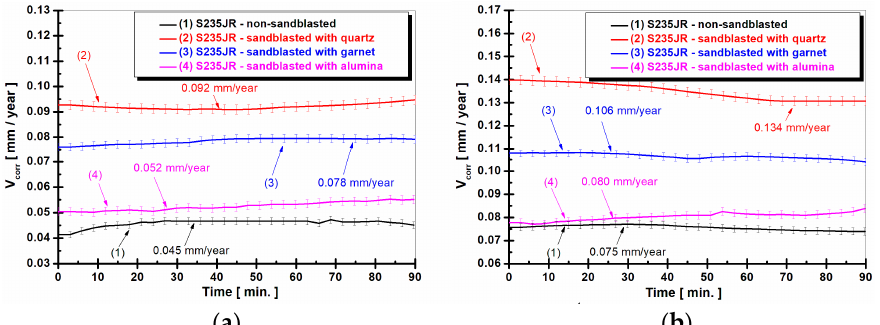
Figure 5. Evolution of corrosion rate (V corr ) of S235JR steel samples immersed in 3.5% NaCl solution for (1) S235JR—non ‐ sandblasted, (2)—S235JR—sandblasted with quartz, (3)—S235JR—sandblasted with garnet, (4)—S235JR—sandblasted with alumina: ( a ) at T 1 = at immersion, ( b ) T 2 = after 336 h from immersion time.